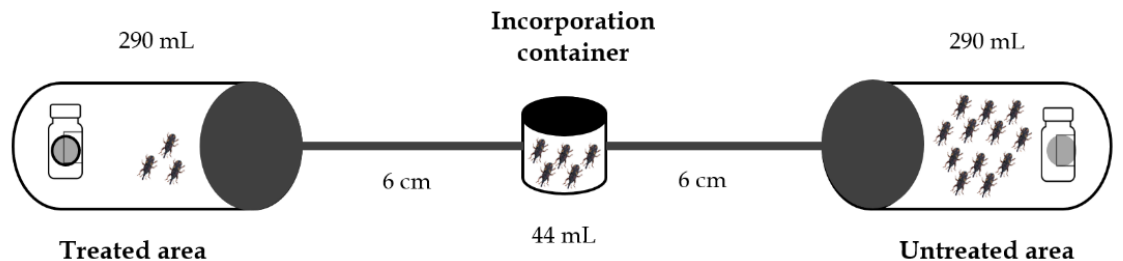
Figure 1. Olfactometer design employed for repellent assay (Own authorship based on data from [26]).